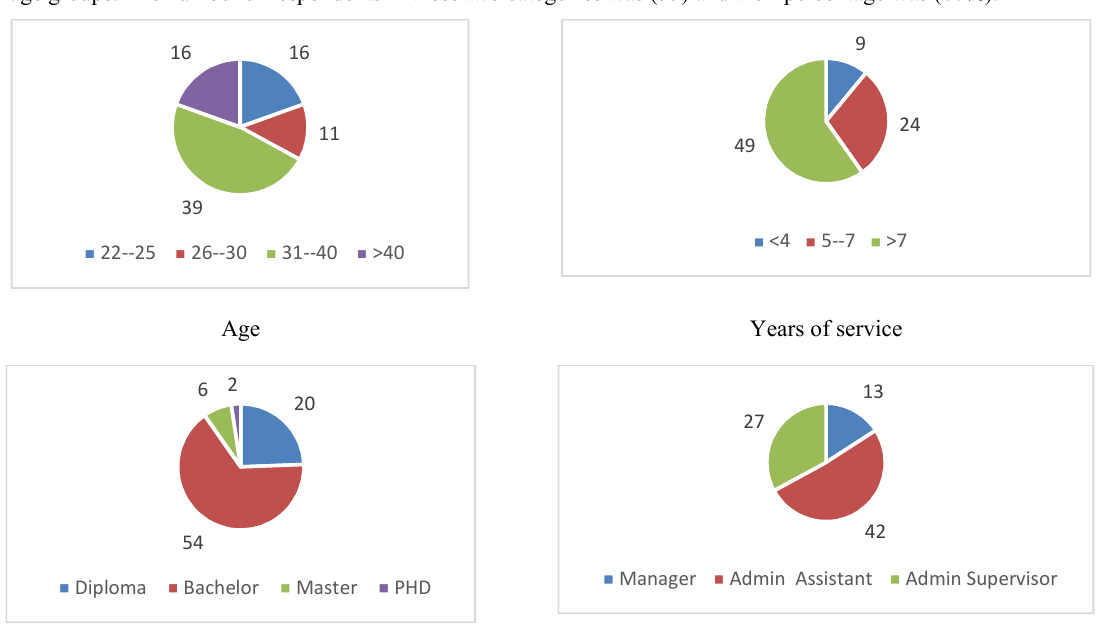
Fig. 2. Personal characteristics of the